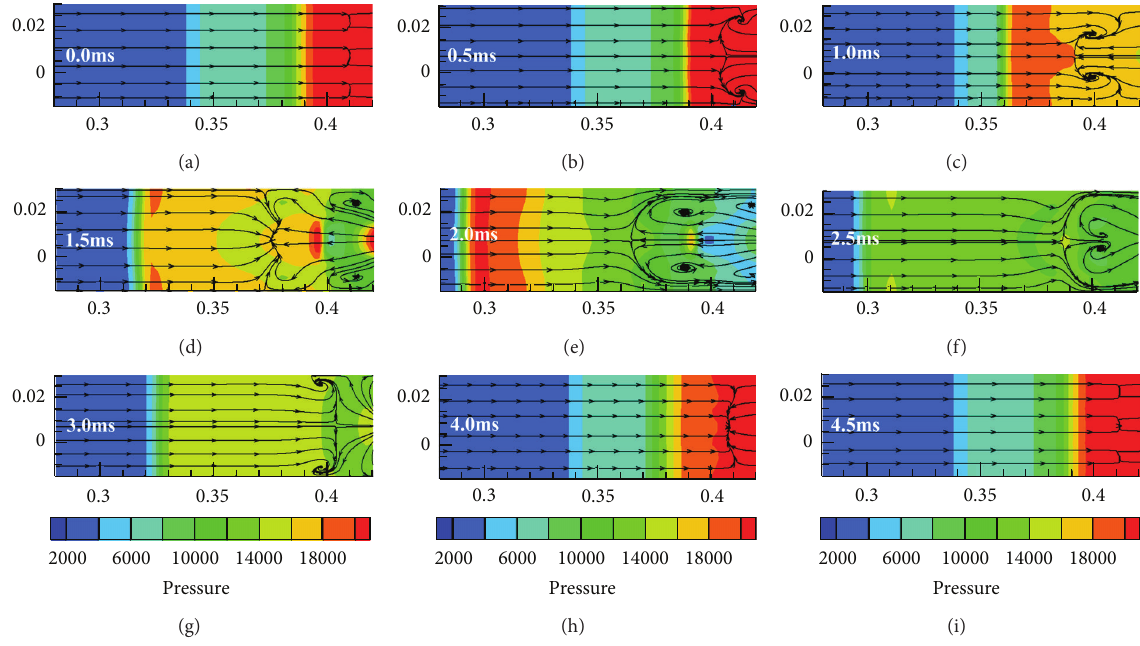
Figure 6: Static pressure contours mixing with streamlines of cross section 𝑌 in a buzz cycle.